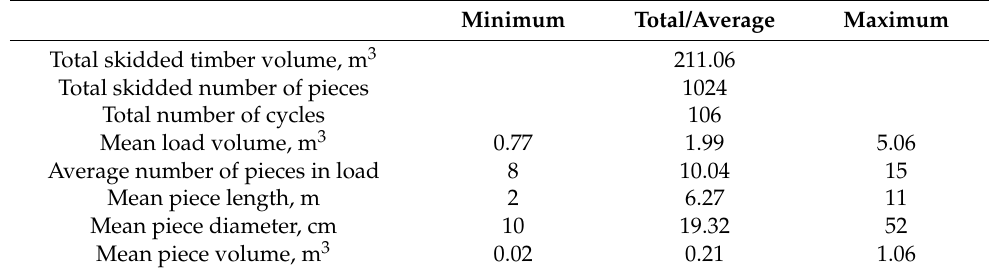
Table 2. Timber extraction structure.